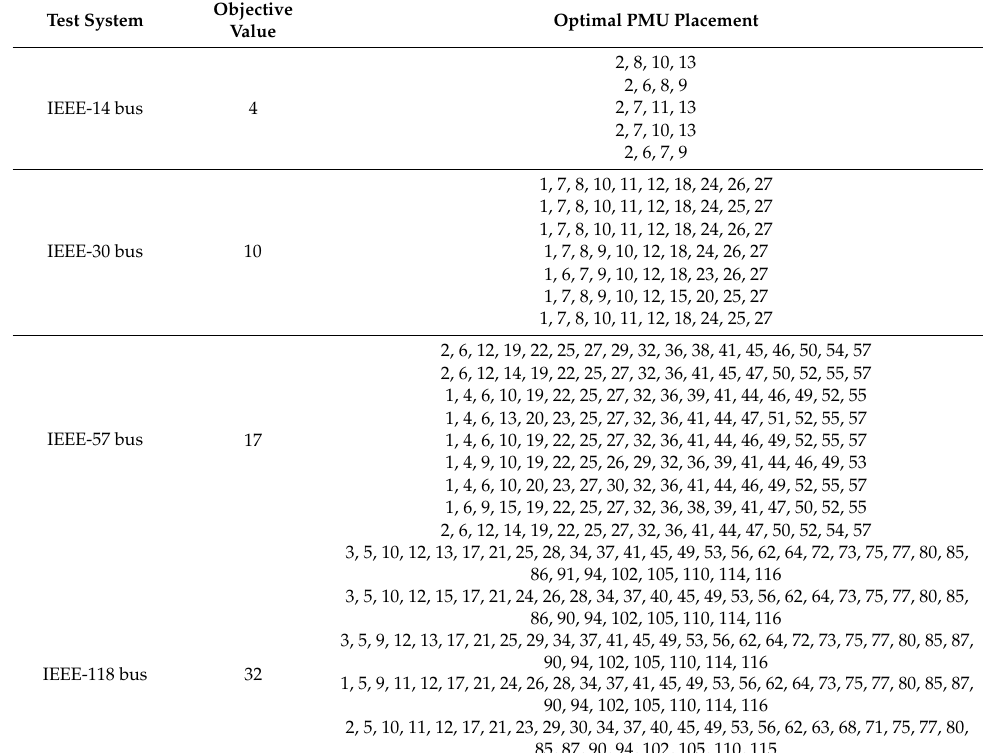
Table A4. Simulation results using the Recursive Quadratic Programming (RQP)